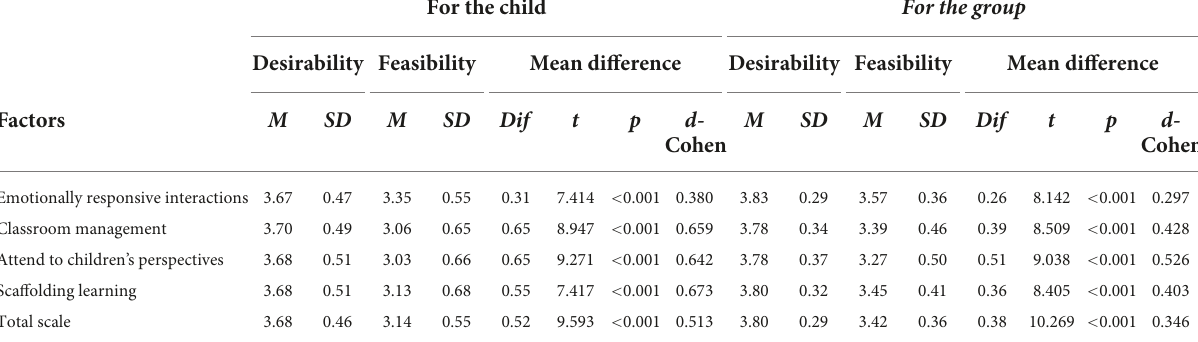
TABLE 6 Percentage of responses per dimension.